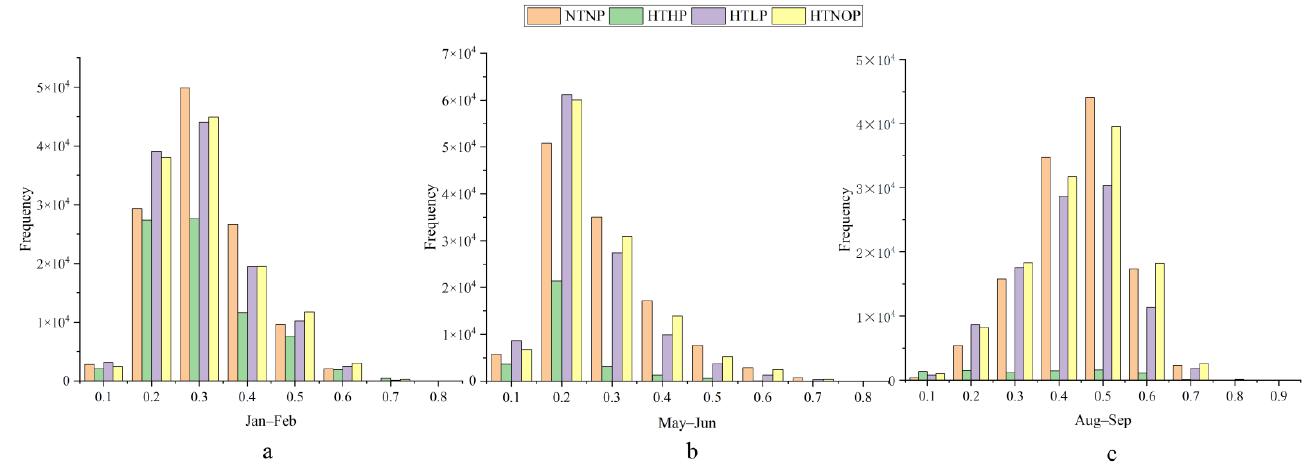
Figure 4. Frequency distribution of EVI under high temperature extreme events combined higher, normal and lower precipitation in three growing seasons of Jan – Feb ( a ), May – Jun ( b ) and Aug – Sep ( c ). (Abbreviations: NTNP – Normal temperature and normal precipitation, HTLP – Higher temperature and lower precipitation, HTNOP – Higher temperature without precipitation, HTHP-Higher temperature and higher precipitation).